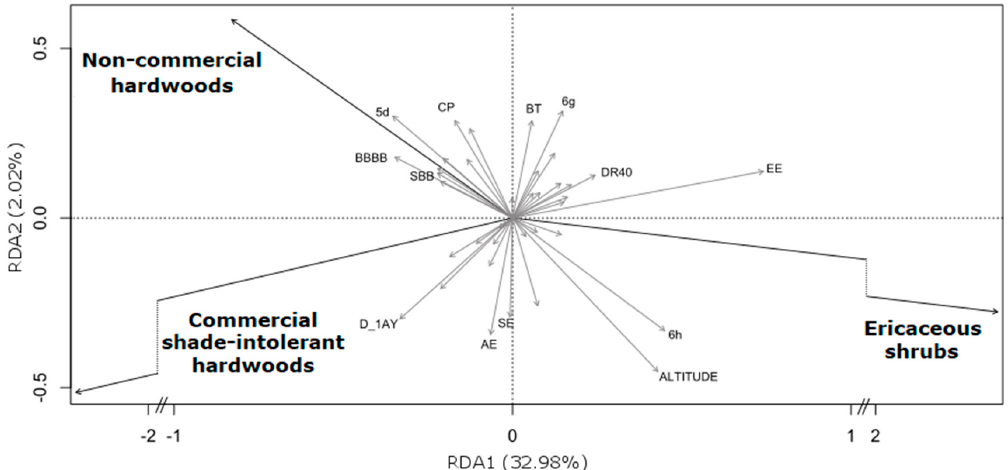
Figure 3. Redundancy analysis (RDA) ordination biplot showing the correlation between competing species groups (black arrows) and explanatory variables selected using a forward selection approach (grey arrows). Only variables with the highest contribution to axes RDA1 or RDA2 are labeled (i.e., coordinate on one axis was >90th quantile or <10th quantile of the distribution of variables coordinates on the same axis). Refer to Table 2 for variables description.